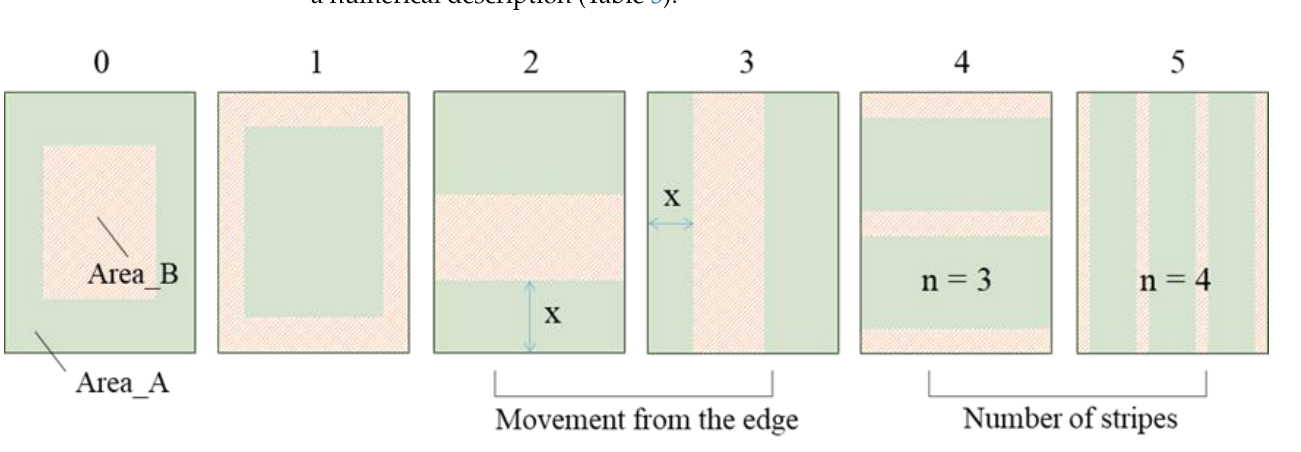
Figure 7. Placement type of wall and ceiling. Table 3. Numerical description of decoration surface placement.